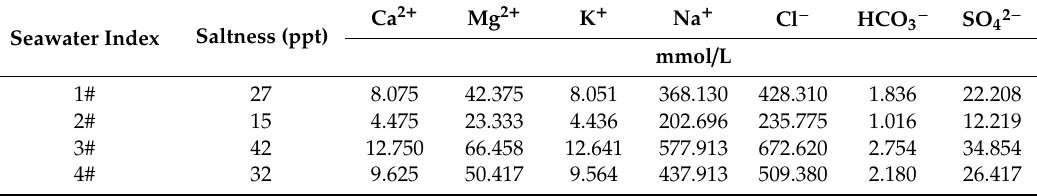
Table 2. Multiple seawater concentrations for one-dimensional flow